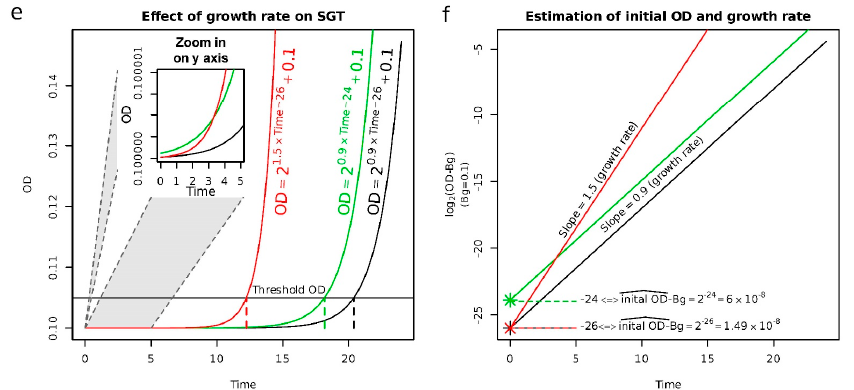
Figure A1. Estimation of the #EqNC by both the Start Growth Time (SGT; [50]) and (cid:92) initial OD (our approach). Left and right panels, respectively, refer to the SGT and (cid:92) initial OD approaches. Panels ( a , b ): representative of real data as analyzed by each method; raw data for SGT and log of the OD minus the background (Bg) for (cid:92) initial OD (see Supplementary method 1 for background estimation). Panel ( a ): the SGT approach yields an estimated SGT of 13, using a threshold of 0.105. Panel ( b ): the linear model gives an (cid:92) initial OD − Bg = 2 − 16.81 . Panels ( c , d ): The standard curve is obtained by quantifying cells by both counting CFUs and analyzing the growth curves, whatever the approach (SGT or (cid:92) initial OD ). If growth rates were similar when computing and using the standard curve, both approaches gave similar results. However, as illustrated in panels ( e , f ), the SGT approach started to be inaccurate when growth rates varied. Panels e and f: Simulated examples showing both the inaccuracy of the SGT approach and the robustness of the (cid:92) initial OD approach in the presence of growth rate variation. Panel ( e ): three theoretical growth curves obtained by assuming growth rates of 1.5, 0.9, and 0.9 cell divisions per hour, for initial ODs of 2 − 26 , 2 − 24 , and 2 − 26 , respectively, for the red, green, and black curves. The SGT approach, based on the OD threshold, would detect more cells in, successively, the red, green, and black curves. However, as illustrated in the inset zoom, this is an artifact induced by growth rate variation. Panel ( f ): log-transformed OD allows the fit of a linear (cid:16) (cid:17) (cid:92) initial OD–Bg model that yields an estimate of both the growth rate and initial OD (log 2